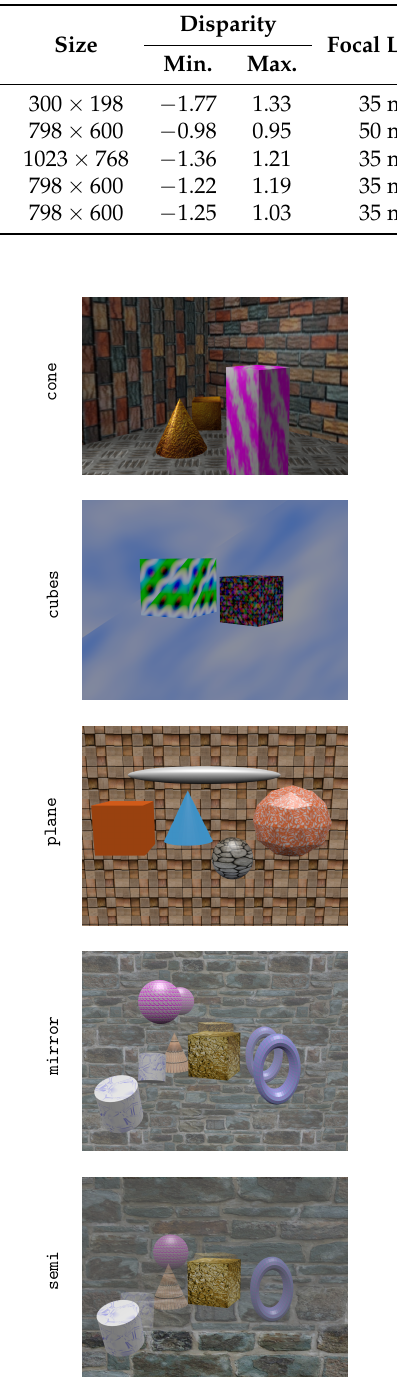
Figure 11. Central images of synthetic test light